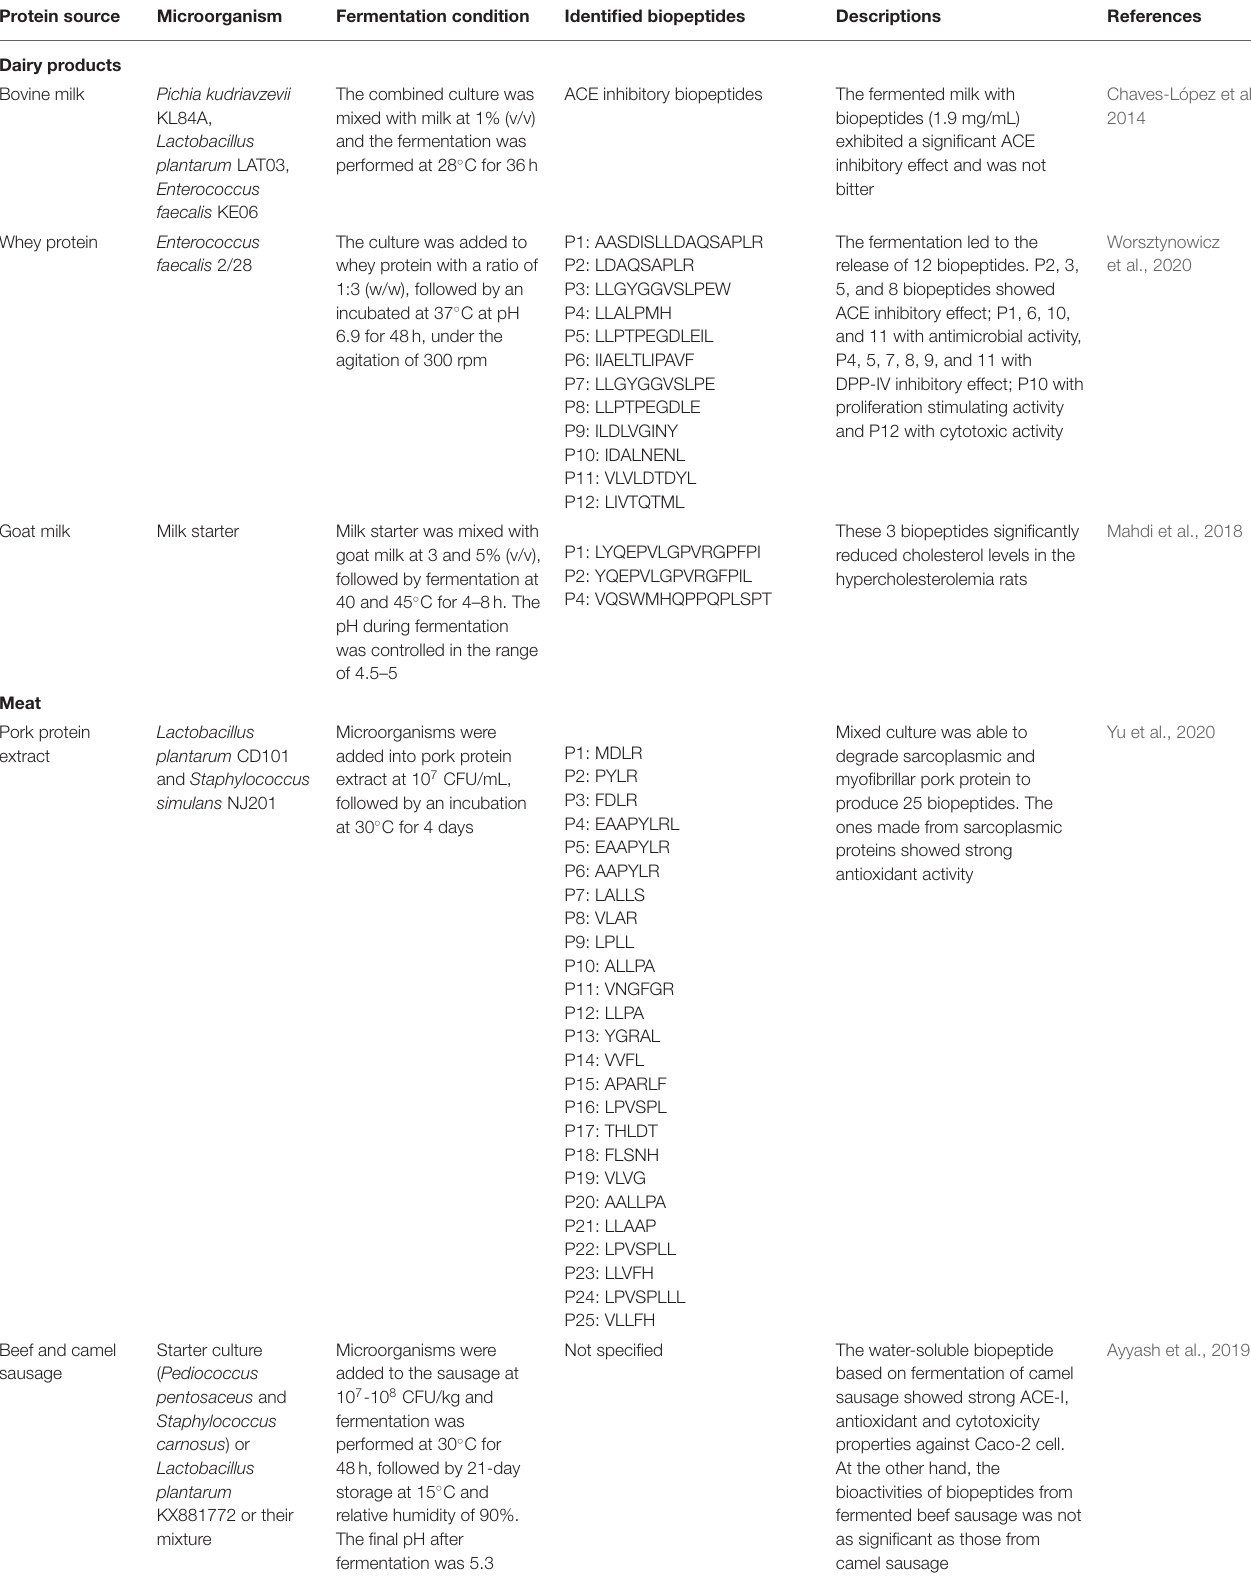
TABLE 1 | Example biopeptides prepared based on microbial fermentation. Protein